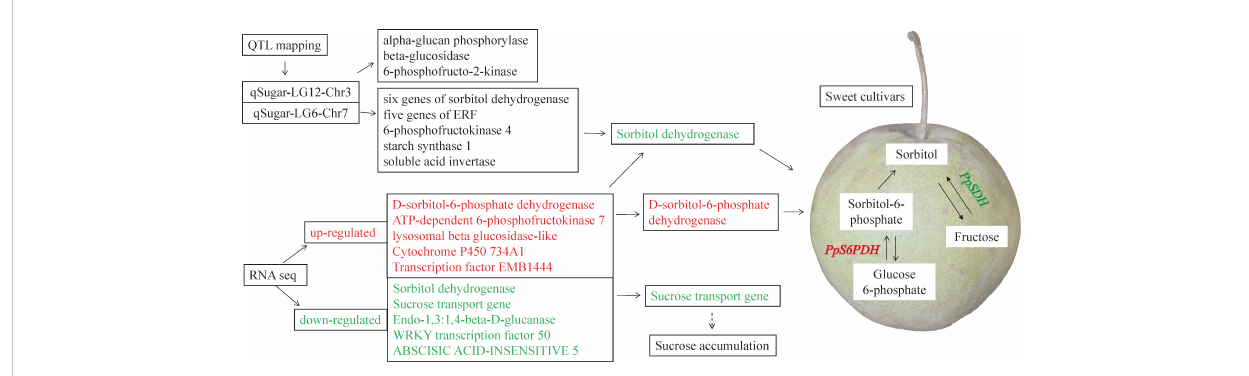
FIGURE 8 Putative regulation network of the sugar content in the sweet cultivars with high content of fructose. The upregulated genes in the sweet cultivars are labeled in red. The downregulated genes are labeled in